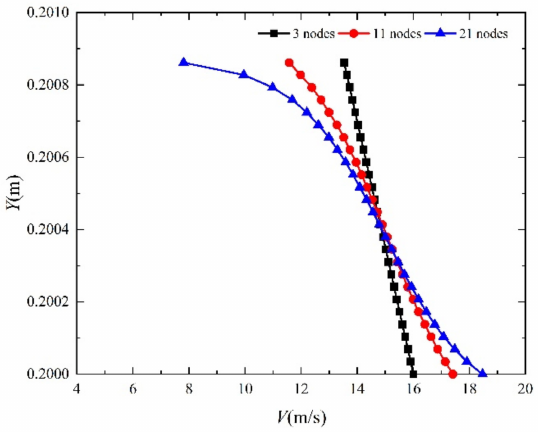
Figure 6. The velocity distribution on the clearance with radial distance.